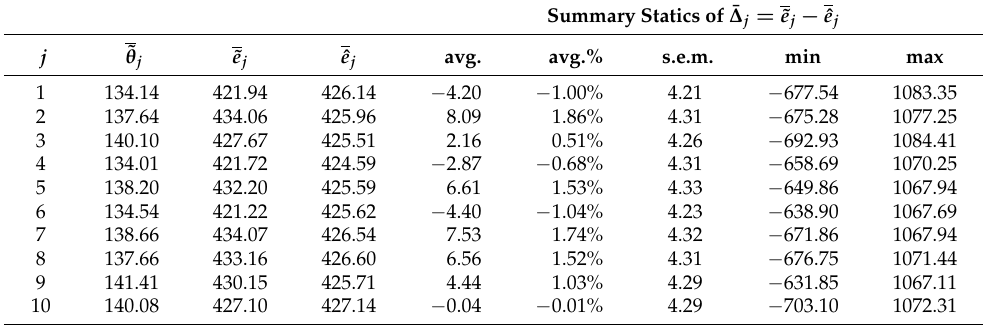
Table 3. Results by DoC event from N = 10,000 simulations ( N c = 9802) generated by Arm A data.